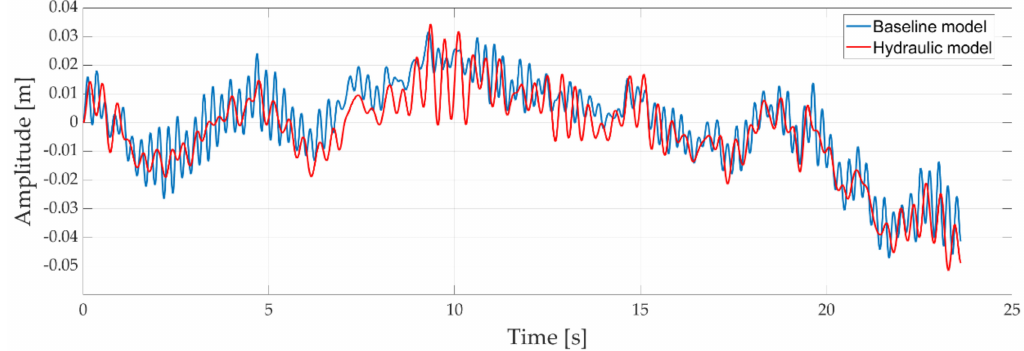
Figure 11. The bounce response to a realistic road profile.